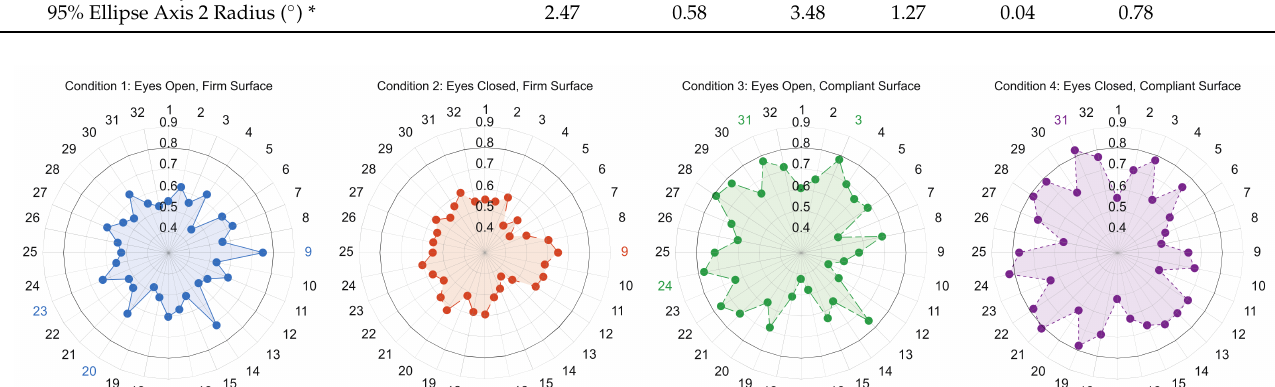
Figure 6. Spider plot representing all balance variables assessed and their linked AUC value between MAA and OA groups. Colored variable numbers round the spider plot indicate variable(s) withheld in the stepwise regression for each condition. Numbers and corresponding variable names: 1—95% Ellipse Radius (rad), 2—95% Ellipse Axis 1 Ra- dius (m/s 2 ), 3—95% Ellipse Axis 2 Radius (m/s 2 ), 4—Centroidal Frequency (Hz), 5—Centroidal Frequency (Coronal) (Hz), 6—Centroidal Frequency (Sagittal) (Hz), 7—Frequency Dispersion (AD), 8—Frequency Dispersion (Coronal) (AD), 9—Frequency Dispersion (Sagittal) (AD), 10—Jerk (m 2 /s 5 ), 11—Jerk (Coronal) (m 2 /s 5 ), 12—Jerk (Sagittal) (m 2 /s 5 ), 13—Mean Velocity (m/s), 14—Mean Velocity (Coronal) (m/s), 15—Mean Velocity (Sagittal) (m/s), 16—Path Length (m/s 2 ), 17—Path Length (Coronal) (m/s 2 ), 18—Path Length (Sagittal) (m/s 2 ), 19—Range (m/s 2 ), 20—Range (Coronal) (m/s 2 ), 21—Range (Sagittal) (m/s 2 ), 22—RMS Sway (m/s 2 ), 23—RMS Sway (Coronal) (m/s 2 ), 24—RMS Sway (Sagittal) (m/s 2 ), 25—Sway Area (m 2 /s 4 ), 26—95% Ellipse Radius ( ◦ ), 27—95% Ellipse Axis 1 Radius ( ◦ ), 28—95% Ellipse Axis 2 Radius ( ◦ ), 29—RMS Sway ( ◦ ), 30—RMS Sway (Coronal) ( ◦ ), 31—RMS Sway (Sagittal) ( ◦ ), 32—Sway Area ( ◦ 2